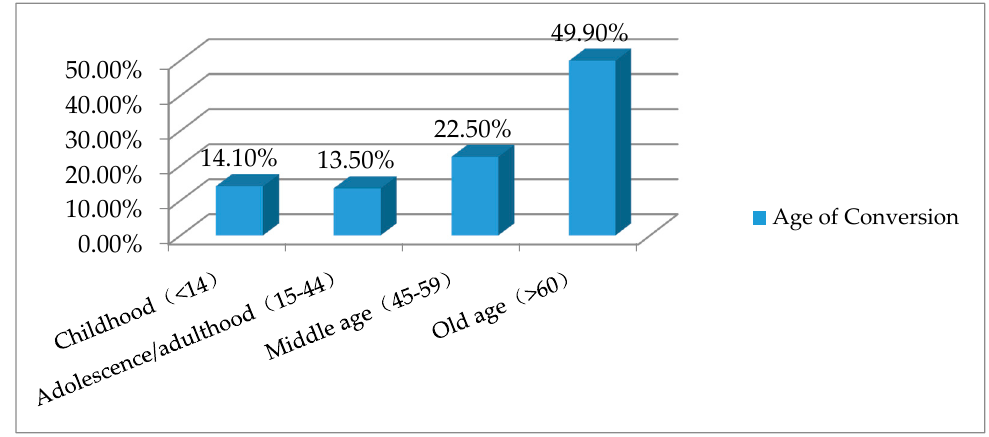
Figure 1. The age when city dwellers started their Christian faith.